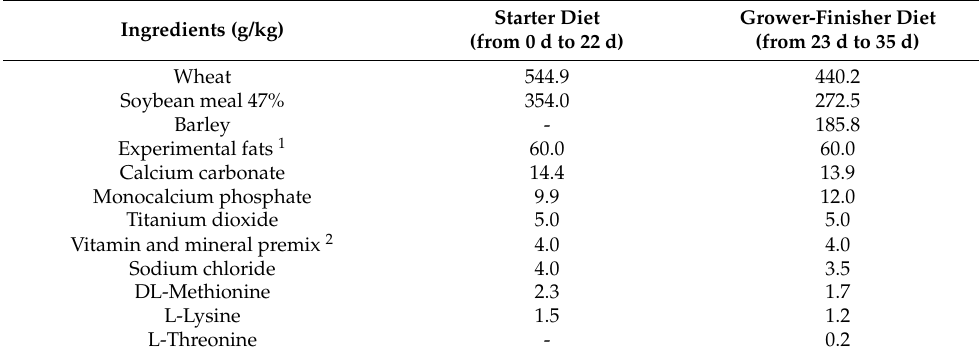
Table 2. Ingredient composition of the experimental basal diet